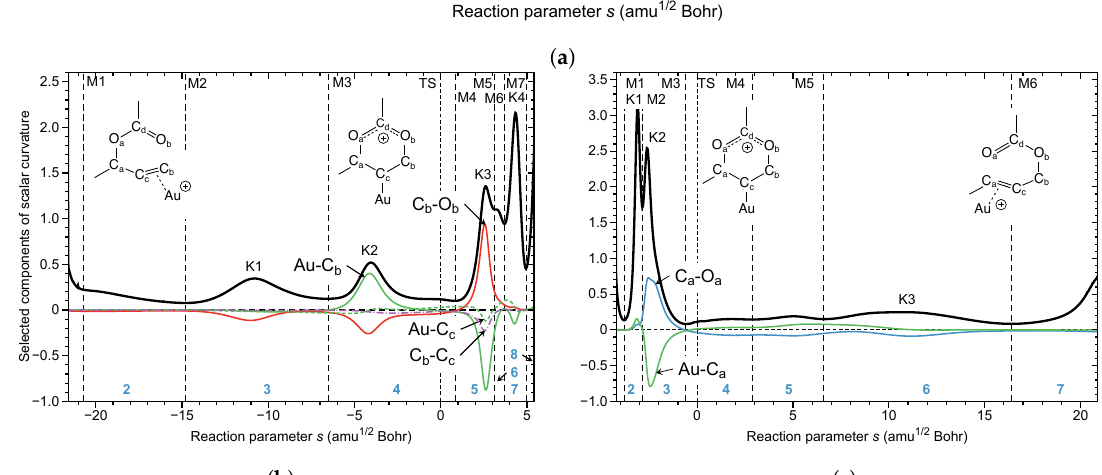
Figure 6. Scalar curvature as a function of the reaction path parameter s (solid black line) for the non-catalyzed [3,3]-sigmatropic rearrangement of allyl acetate (Figure 6 a ) and for the two steps of the Au(I)-NHC catalyzed reaction (Figure 6 b , c ). The borders of the reaction phases are indicated by vertical dashed lines at curvature minima M1, M2, M3, etc. The reaction phases are indicated by blue numbers. Curvature maxima are given as K1, K2, K3, etc. The TS at s = 0 amu 1/2 Bohr is also indicated by a vertical dashed line. B3LYP/6-31+G(d,p)/SDD(Au) level of theory. (Reprinted with permission from [110]; copyright 2020 from Taylor and